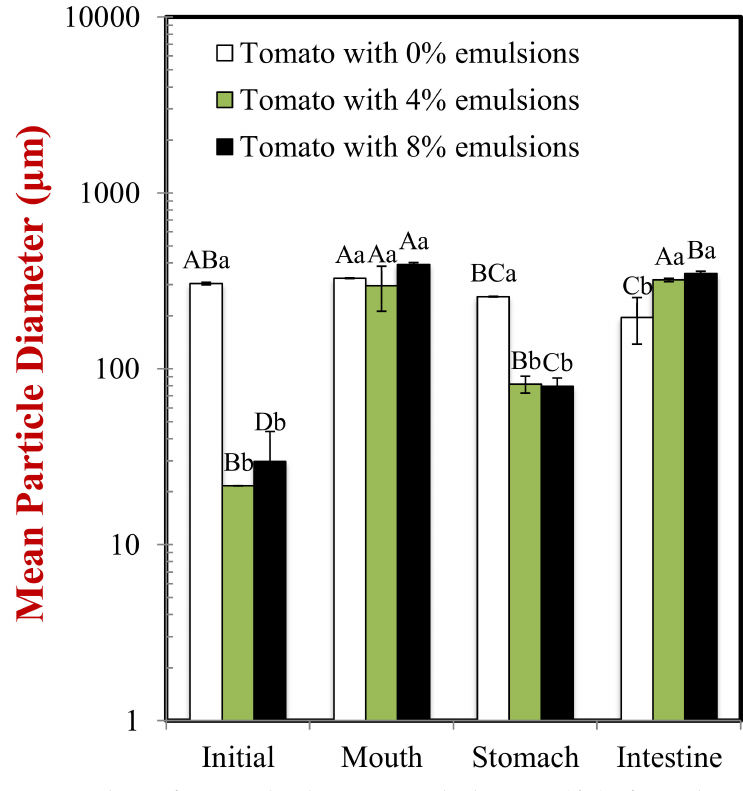
Figure 1. Changes in the surface-weighted mean particle diameter ( d 32 ) of samples as they passed through a simulated gastrointestinal tract. Samples designated with upper-letters ( A , B , C ) were significantly di ff erent (Duncan, p < 0.05) when compared between di ff erent GIT conditions (same lipid content). Samples with di ff erent lower-case letters (a, b, c) were significantly di ff erent (Duncan, p < 0.05) when compared between di ff erent lipid content (same GIT